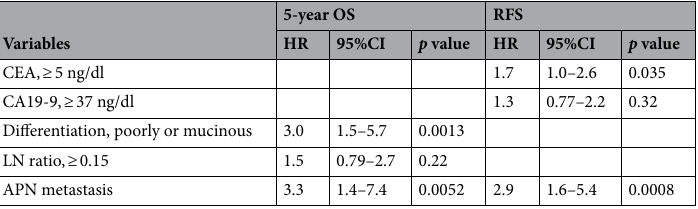
Table 3. Multivariate analyses of risk factors for 5-year OS and RFS. OS: overall survival, RFS: relapse free survival, HR: hazard ratio, CI: confidence interval, CEA: carcinoembryonic antigen, CA19-9: carbohydrate antigen 19-9, LN ratio: the number of metastatic LN divided by that of retrieved LN, APN: apical lymph node.